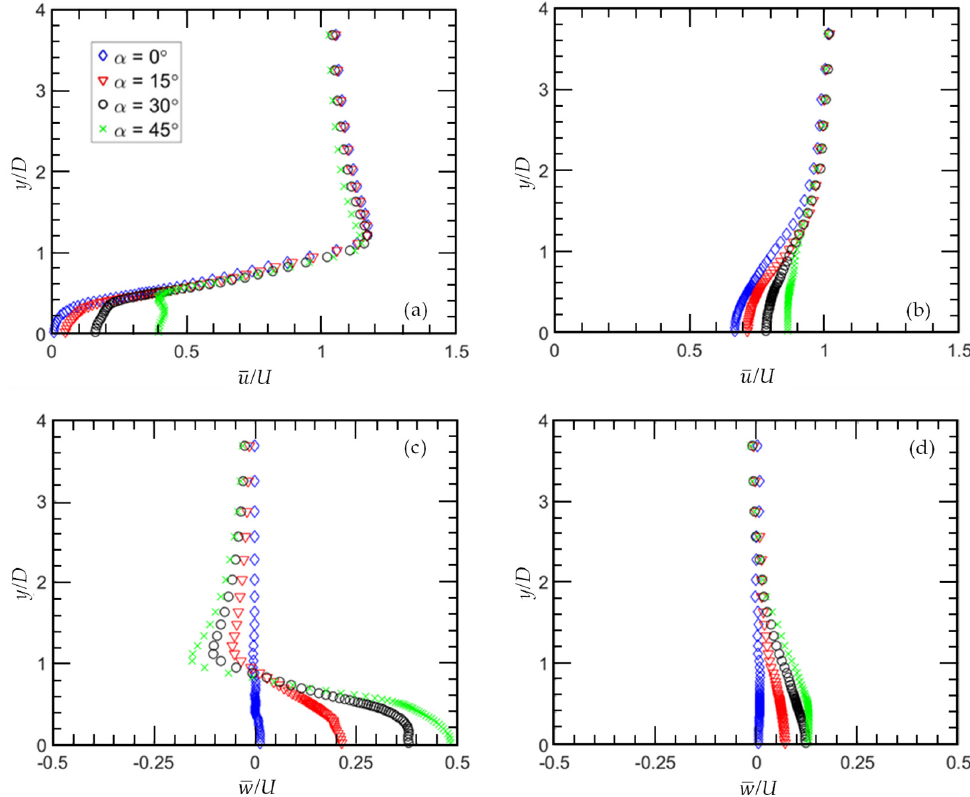
Figure 5. Time-averaged profiles of the streamwise ( u / U ) and spanwise ( w / U ) velocity for different yaw angles at two downstream locations. ( a , c ) x = 1 D ; ( b , d ) x = 10 D .